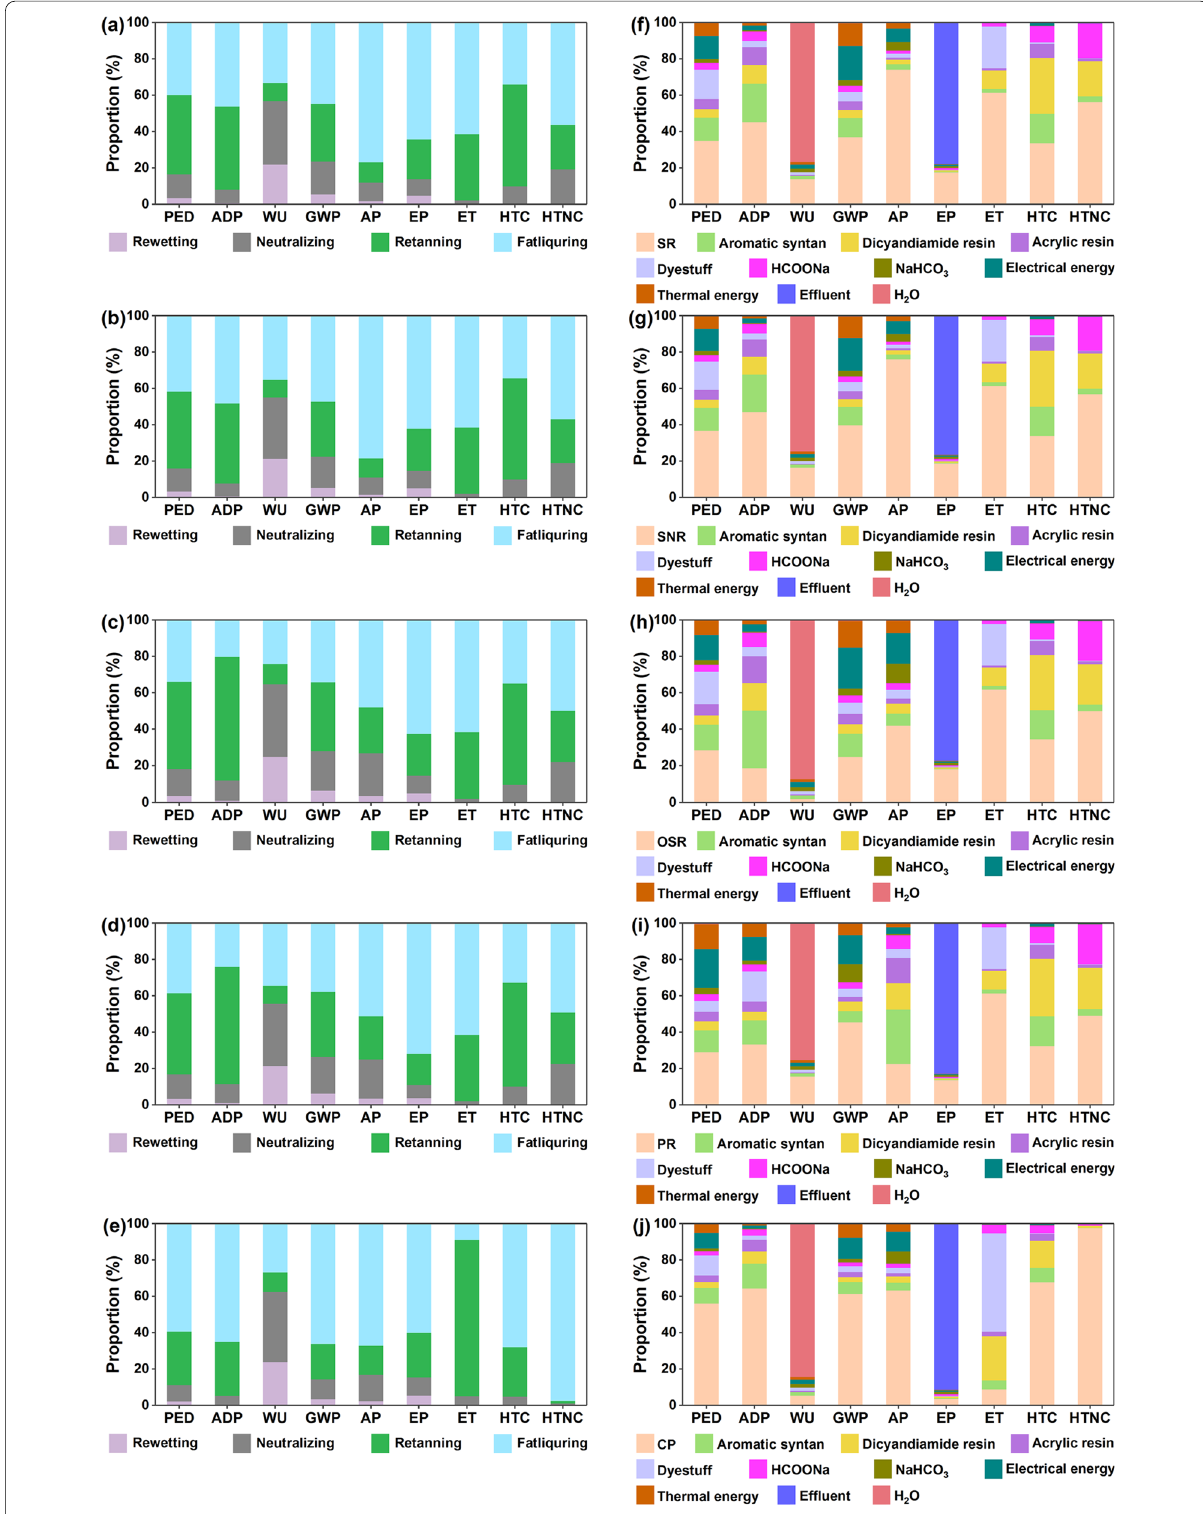
Fig. 7 Contribution of operations for SR ( a ), SNR ( b ), OSR ( c ), PR ( d ), and CP ( e ) use processes. Contribution of chemicals and energy for SR ( f ), SNR ( g ), OSR ( h ), PR ( i ), and CP ( j ) use processes (obtained from the characteristic values shown in Additional file 1: Tables